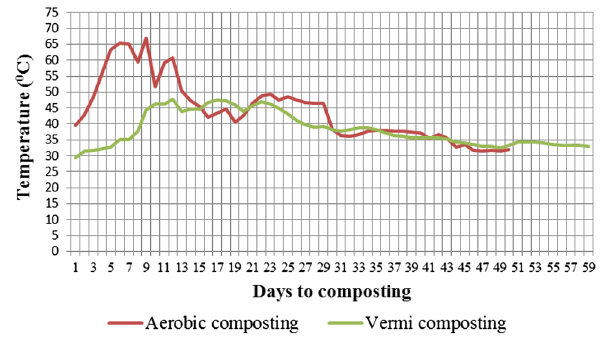
Fig. 2 Changes in daily mean temperature at 0.15 m depth under dif- ferent composting methods